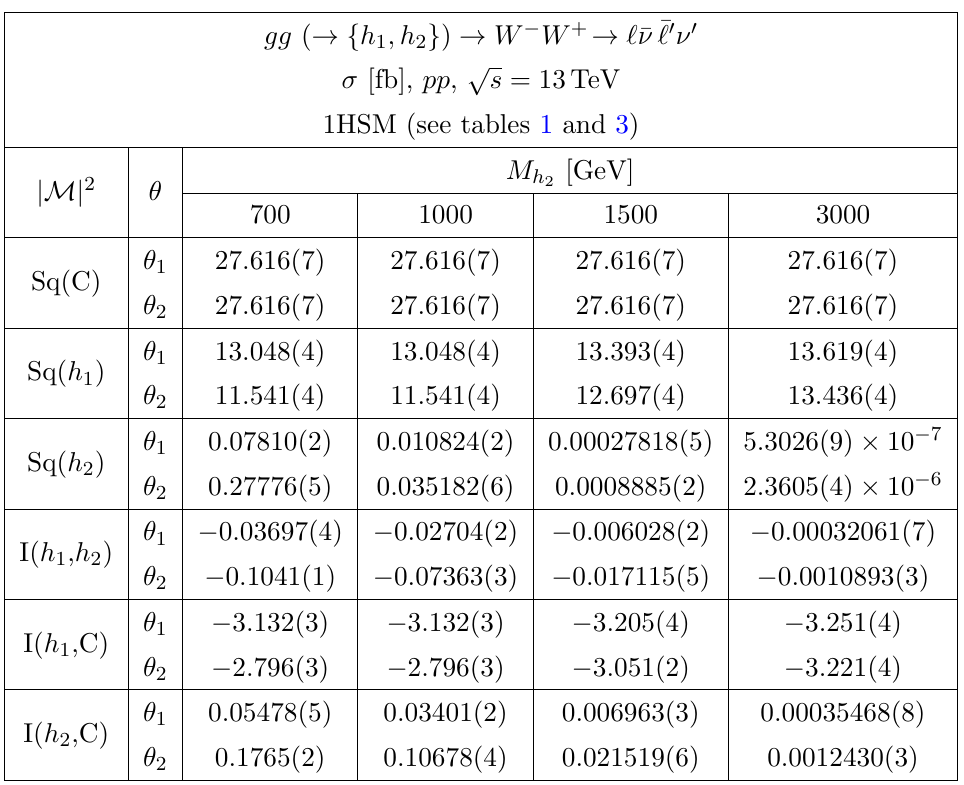
h ; h W (cid:0) W + ‘ (cid:22) (cid:23) (cid:22) ‘ 0 (cid:23) 0 in pp collisions at p s = 13 TeV 1 2 g ) ! ! f ! = 125 GeV, M h = 700 ; 1000 ; 1500 ; 3000 GeV 1 2